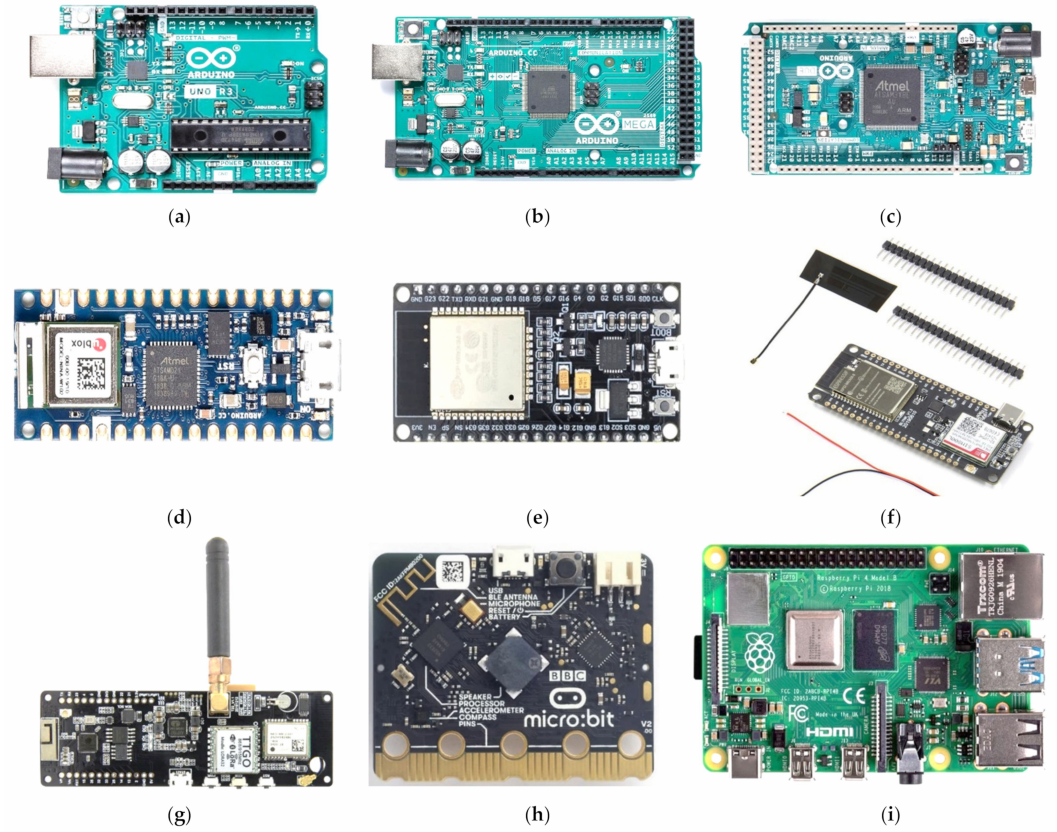
Figure 11. ( a – i ) Arduino Uno R3 [86], Arduino Mega 2560 [86], Arduino Due [86], Arduino Nano 33 IoT [86], ESP-WROOM-32S DEV (also called NodeMCU (ESP32S)) [85], TTGO T-Call ESP32 with SIM800L GPRS module [85], TTGO LoRa32 SX1276 board [85], ESP32 TTGO T-Beam V1.1 [85], BBC Micro: bit V2 [114], and Raspberry Pi 4 Model B—8 GB [87], respectively; Courtesy of the